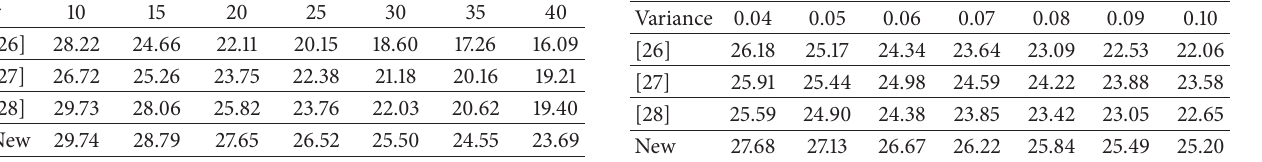
Table 1: PSNR of different algorithms with different Gaussian noise levels for Miss America video sequence.